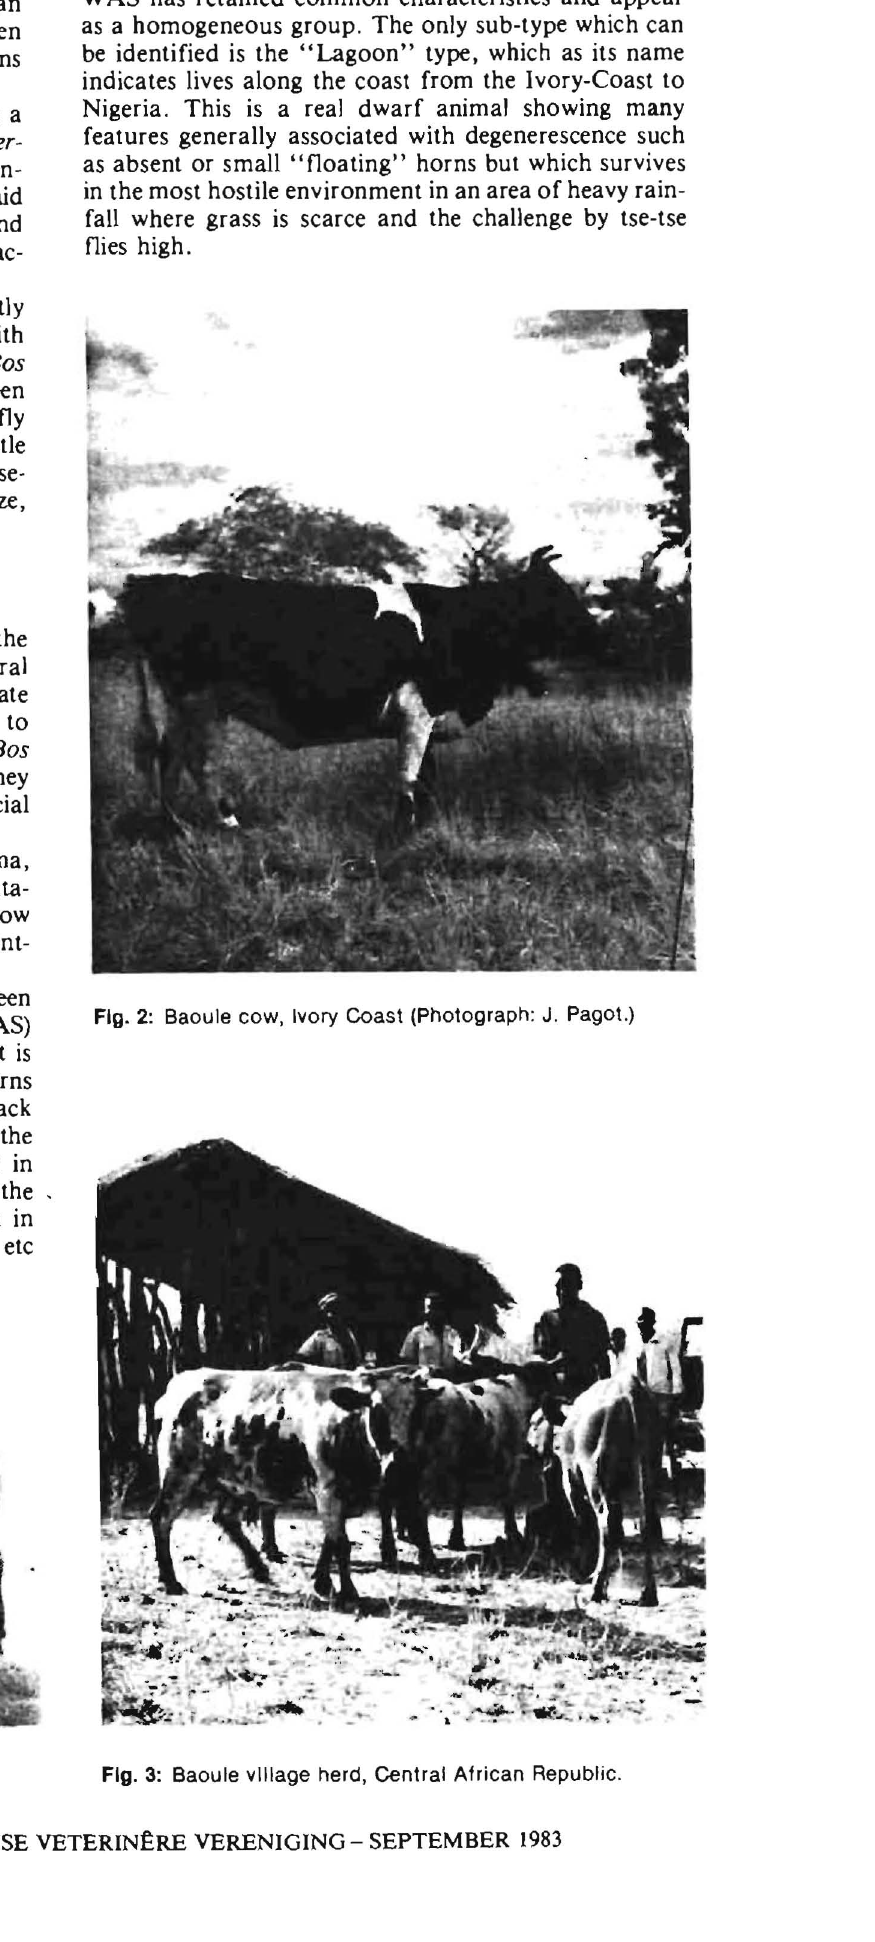
fig. 1: N'Dama bull, Mali. (Photograph: J. Pago!.)